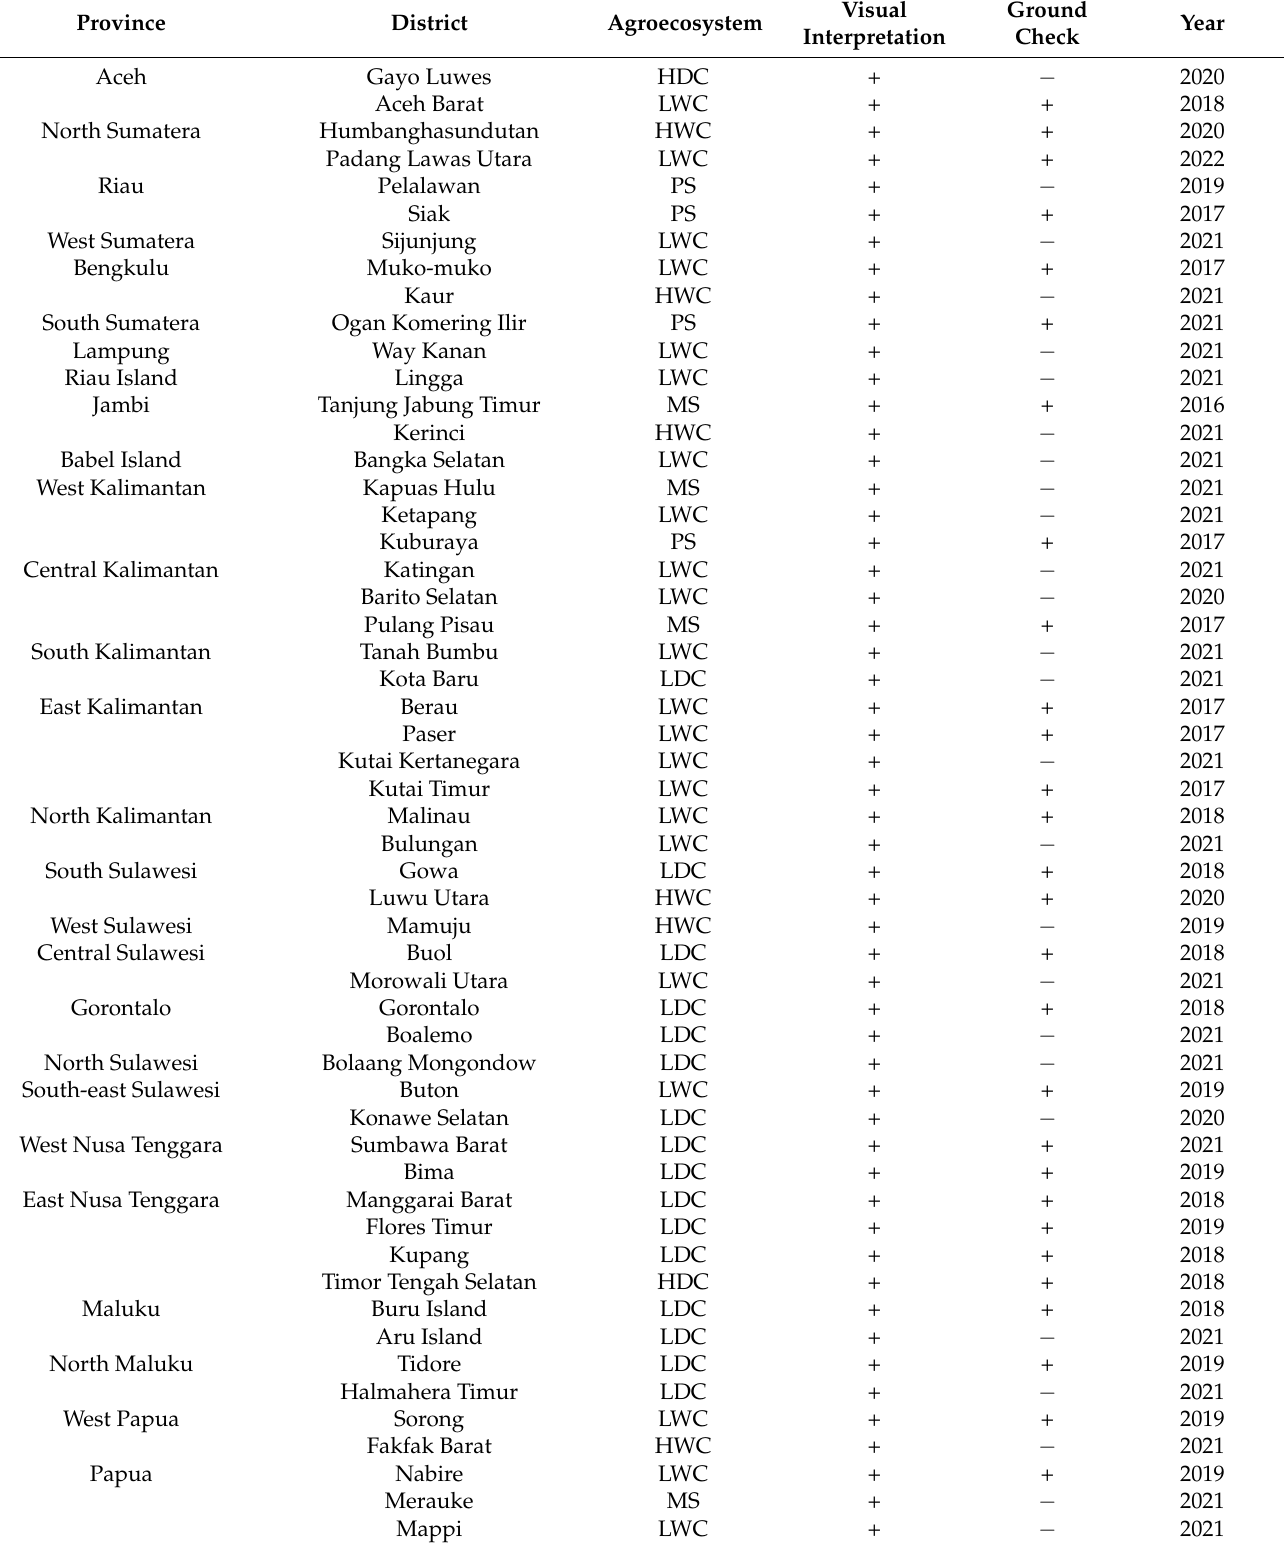
Table 1. The district samples for the visual interpretation and ground check of